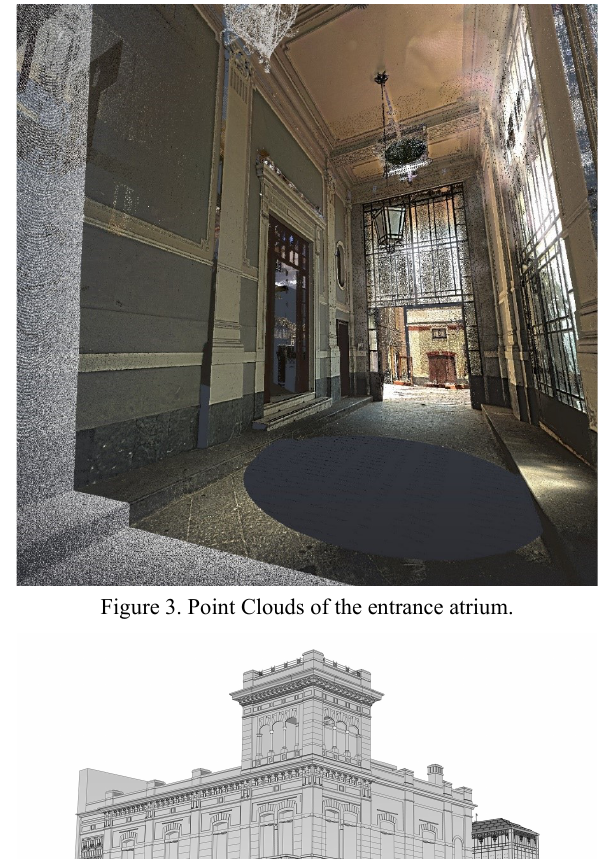
Figure 4. Perspective view of the HBIM